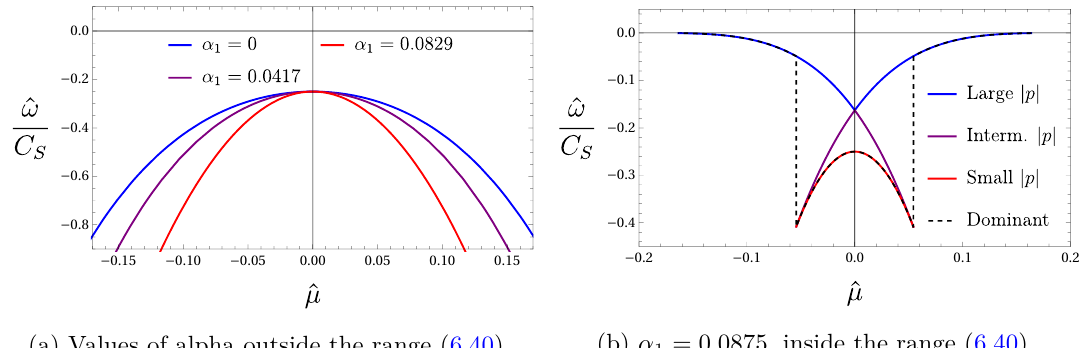
Figure 3. We show the rescaled grand potential ˆ ω with respect to ˆ µ with β = 0 in d = 4 dimensions. Left plot: we take α 1 / 12 , so that there is a single phase for every value of ˆ µ . Right plot: we 1 ≤ take α within the interval (6.40), and we see that there appear three phases with different values of 1 p . The dominant configuration is denoted with a black dashed line. We observe a zeroth-order phase transition. Also note that there are no solutions beyond a maximum value of ˆ µ (corresponding to ˆ µ = p α 2 max 1 /